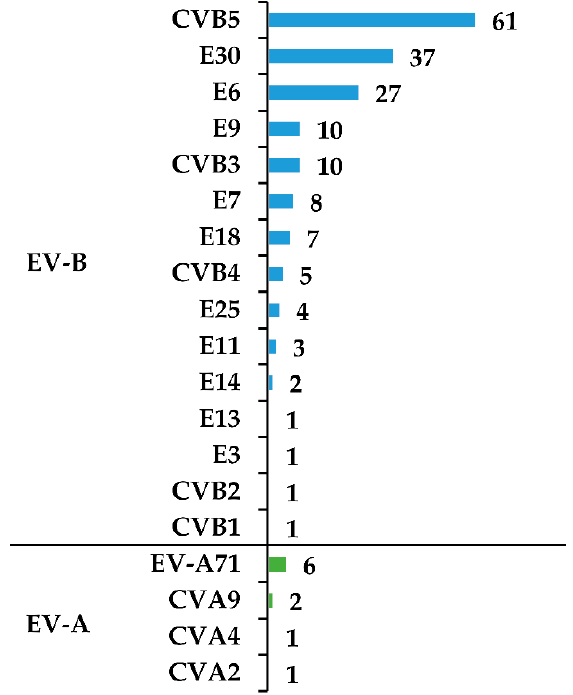
Figure 2. Enterovirus types detected in children with infection of the CNS attributed to enteroviruses. Abbreviations: EV-A, enterovirus A species; EV-B, enterovirus B species; CV, coxsackievirus; E, echovirus .